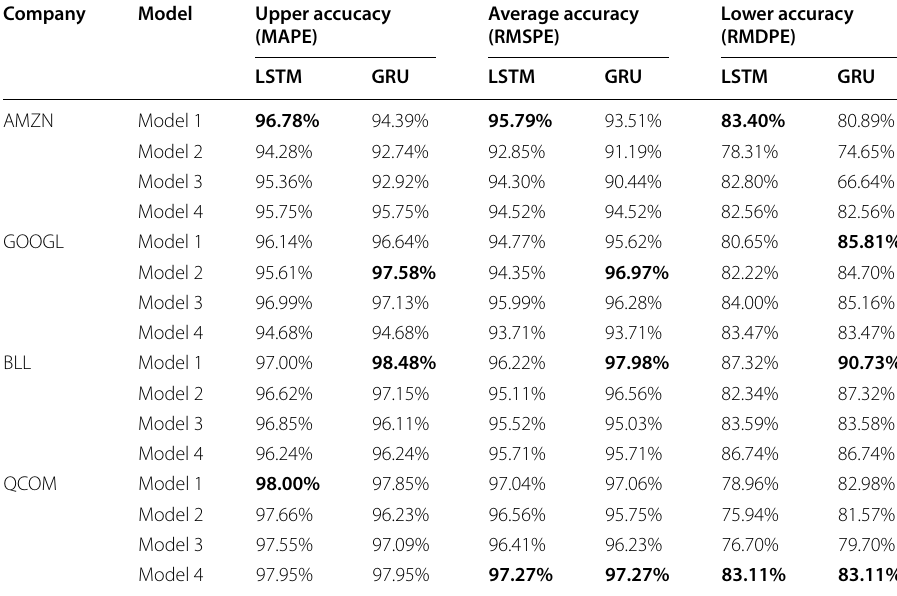
Table 4 Trained accuracy of the LSTM and GRU architectural models